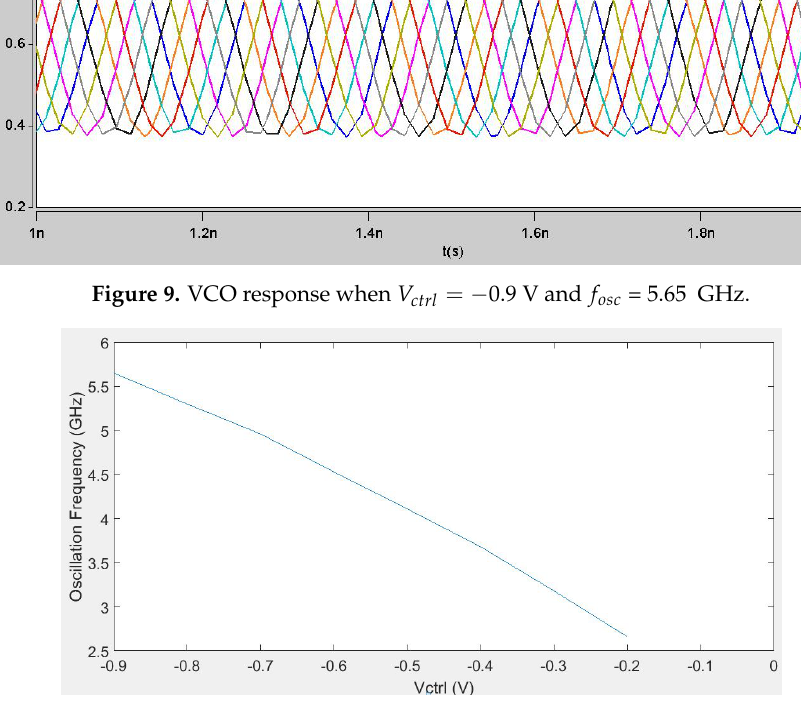
Figure 10. Oscillation frequency vs. control voltage